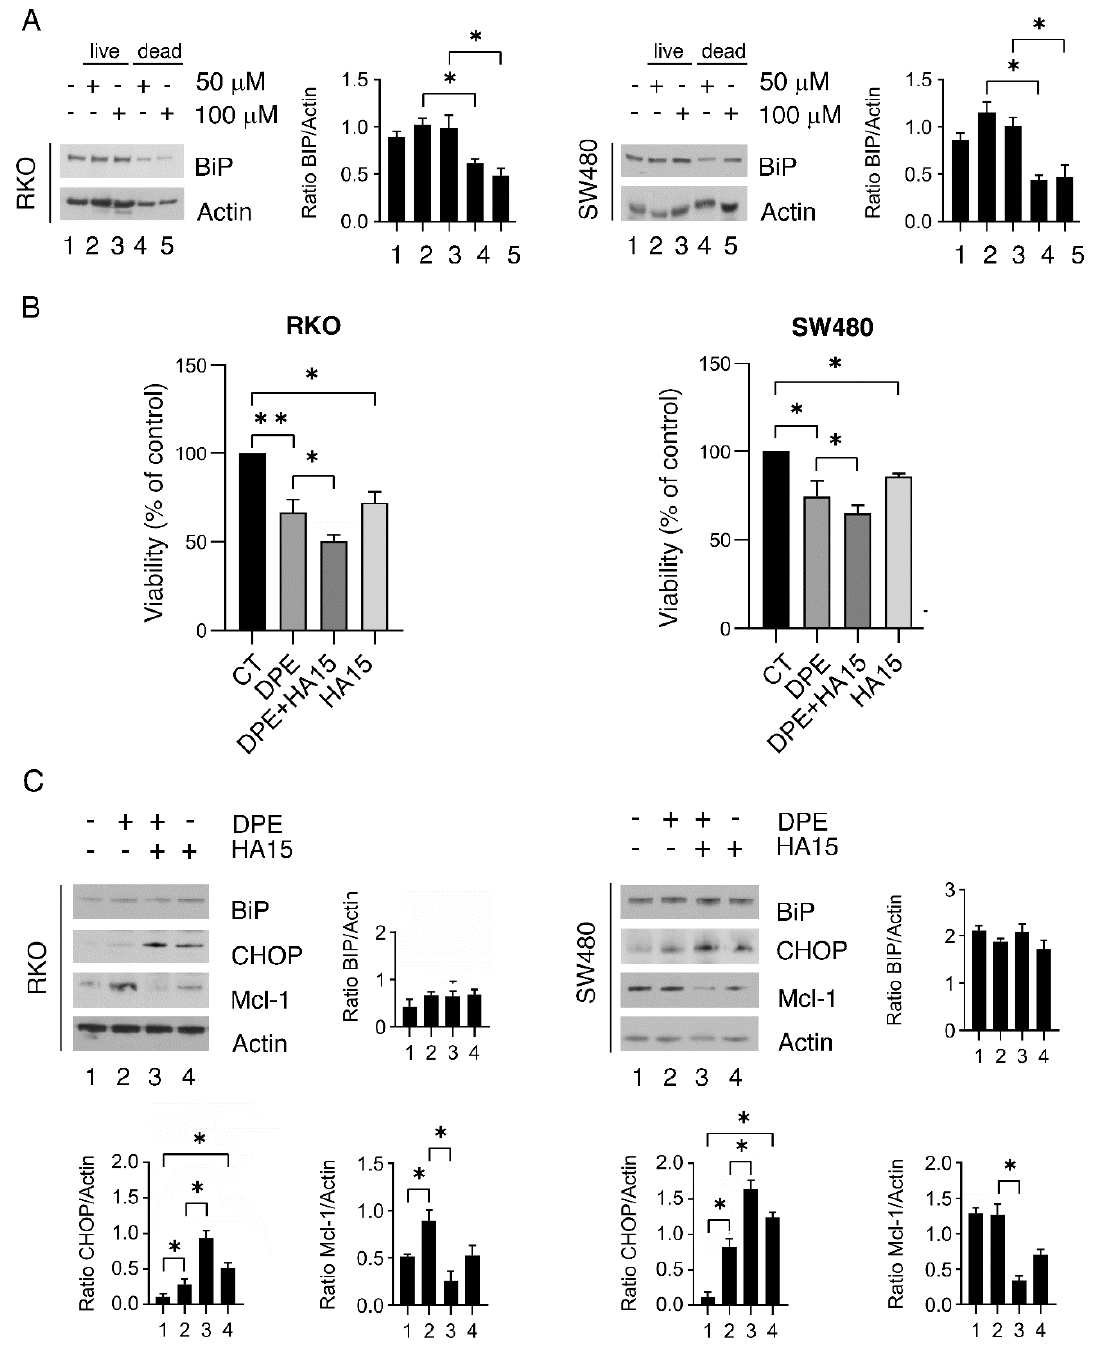
Figure 4. BiP is upregulated in the fraction of cells resistant to the DPE treatment. ( A ) RKO and SW480 were treated with DPE (50 or 100 µ M) or left untreated as controls. After 48 h, the expression of BiP in living cells or dead cells was evaluated via Western blot analysis. β -Actin was used as the loading control. The histograms represent the means plus S.D. from the densitometric analysis of the ratio between BiP and β -actin. ( B ) The cell viability levels of RKO and SW480 cell lines pre-treated with HA15 (10 µ M) and then treated with DPE (50 µ M) or left untreated as control (CT) were measured via trypan blue exclusion assay after 48 h of culture. ( C ) RKO and SW480 were pre-treated with HA15 (10 µ M) and then treated with DPE (50 µ M) or left untreated as control. After 48 h, the expression levels of BiP, CHOP, and Mcl-1 were evaluated via Western blot analysis. β -Actin was used as the loading control. The histograms represent the means plus S.D. from the densitometric analysis of the ratio between the protein and β -actin. Note: ** p < 0.01, * p <